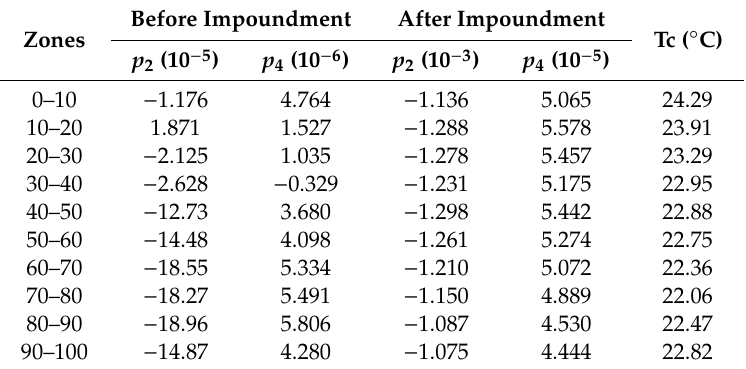
Figure 13. The sensitivity index (SI) and sensitivity variation index (SVI) for the NDVI–precipitation response in 0–10 km zones. Table 6. SI of NDVI–precipitation and temperature thresholds.